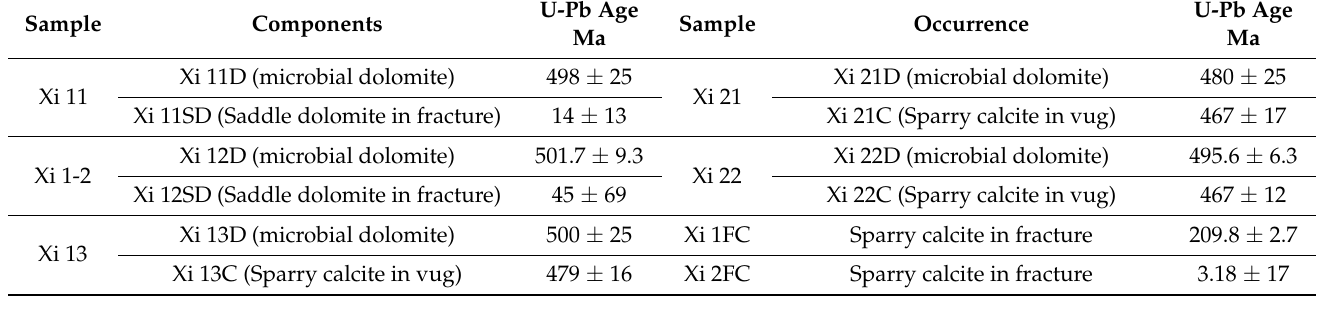
Table 4. The result of U-Pb isotopic dating.